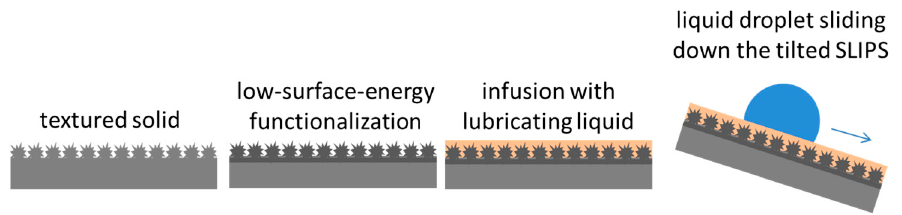
Figure 10. Fabrication of slippery liquid-infused porous surfaces (SLIPS) by infiltrating a functionalized textured solid with a lubricating liquid to form a physically smooth and chemically homogeneous lubricating film on the surface, enabling the test liquid to easily slide down on the tilted SLIPS.